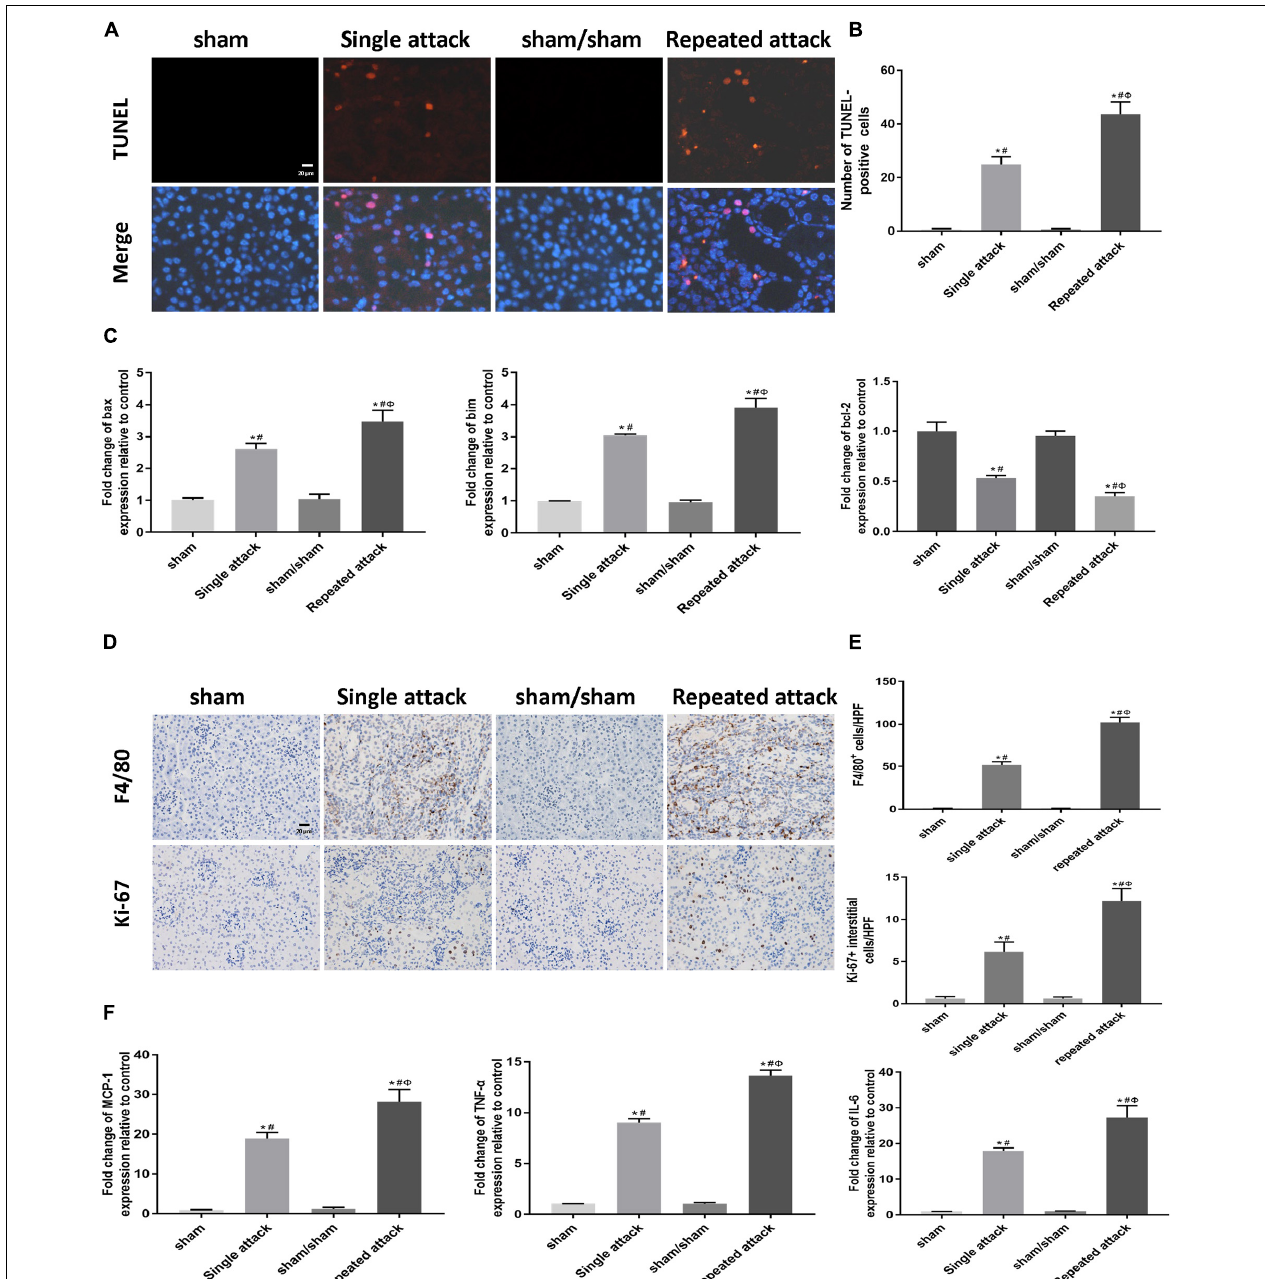
FIGURE 7 | Increased apoptosis and inflammation were associated with the acceleration of the AKI-to-CKD transition in mice exposed to repeated IRI attacks. (A) TUNEL staining to measure the apoptosis of renal tubular epithelial cells in kidneys at day 14 after the first renal ischemia attack (original magnification × 400; Scale bar, 20 µ m). (B) Quantitative analysis of the number of apoptotic cells in each group. (C) Expression of proapoptotic genes (bax and bim) and the antiapoptotic gene bcl-2 were measured by real-time PCR. (D) Immunohistochemical staining of F4/80 (a macrophage marker) and Ki-67 (a marker of proliferation) at day 14 after the first renal ischemia attack (original magnification × 400; Scale bar, 20 µ m). (E) Semiquantitative data of F4/80 and Ki-67 staining in different groups of mice. (F) Expression of inflammatory mediators (MCP1, TNF- α , and IL-6) was measured by real-time PCR. Data are presented as the means ± SEM of four experiments. n = 6; ∗ P < 0.05 vs. the sham control group. # P < 0.05 vs. the sham/sham group. (cid:56) P < 0.05 vs. the single-attack